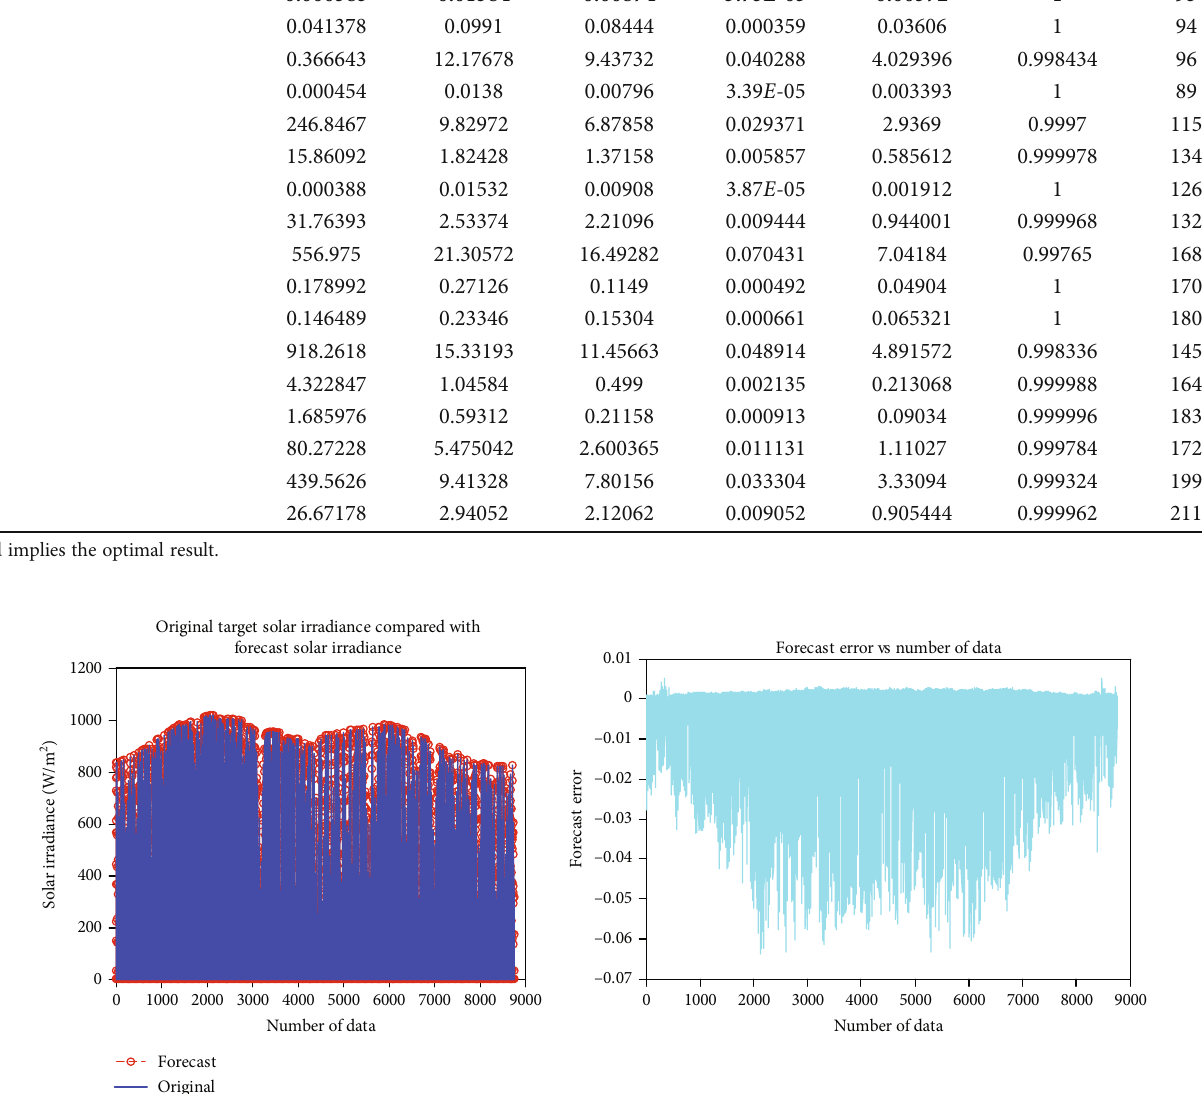
hidden neurons is graphically represented in Figure 21(b): CMMLPNN-based forecasting model forecasting error vs. a number of hidden neurons. The hidden neurons vary, and the neural network ’ s stability is also varied, which causes the irregular nature of the forecasting errors. The computa- tional time-based impact on the hidden neurons is shown in Figure 22.